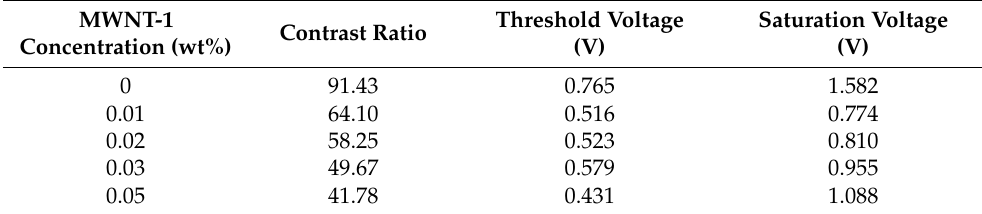
Table 1. The contrast ratio, threshold voltage, and saturation voltage in different concentrations of MWNT-1-doped TN